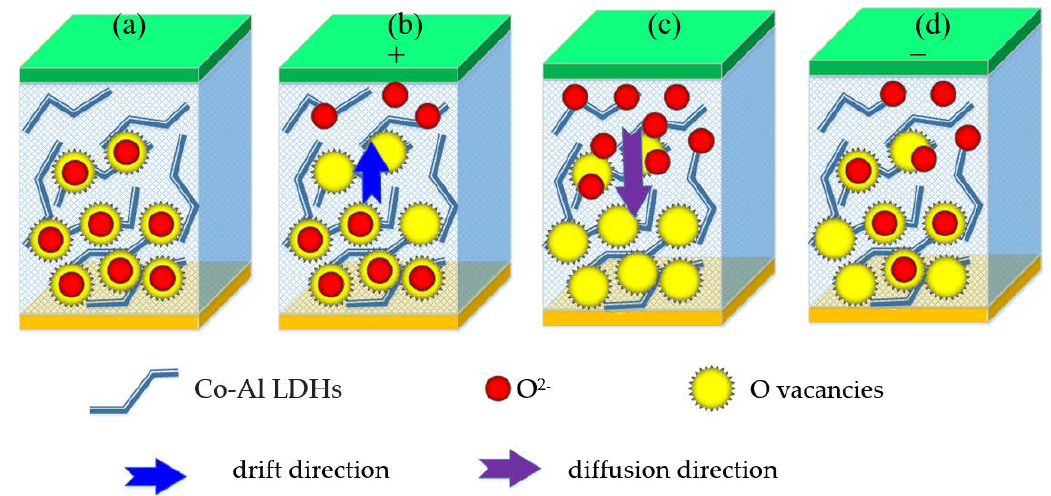
Figure 8. Schematic diagram of resistive switching of the Co–Al LDHs memristor. ( a ) Oxygen ion and oxygen vacancy when no voltage is applied to the device. ( b ) Oxygen ion drift when a positive voltage is applied on the Al electrode. ( c ) Diffusion of oxygen ions due to concentration gradients. ( d ) The trend of oxygen ion movement after applying negative voltage to Al electrode.